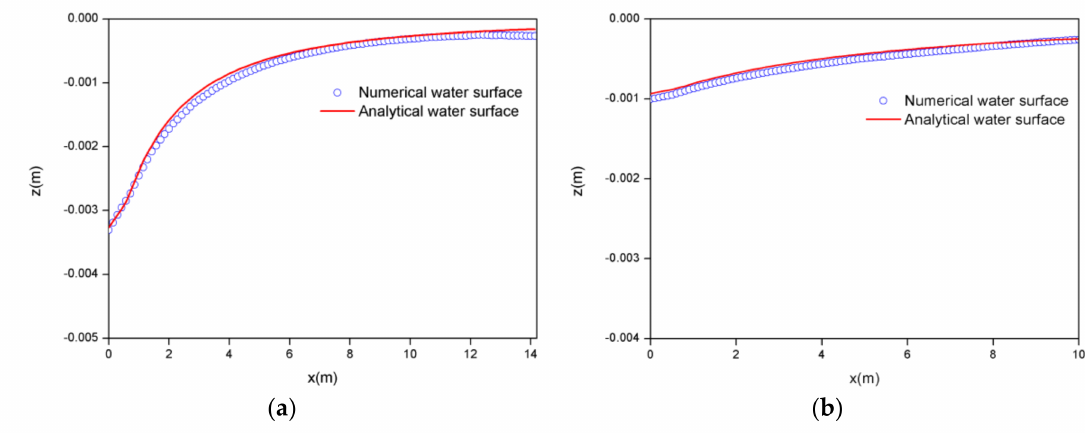
Figure 17. Comparisons between simulated and analytical water surface on the distorted mesh along: ( a ) the diagonal section; ( b ) the horizontal-symmetry